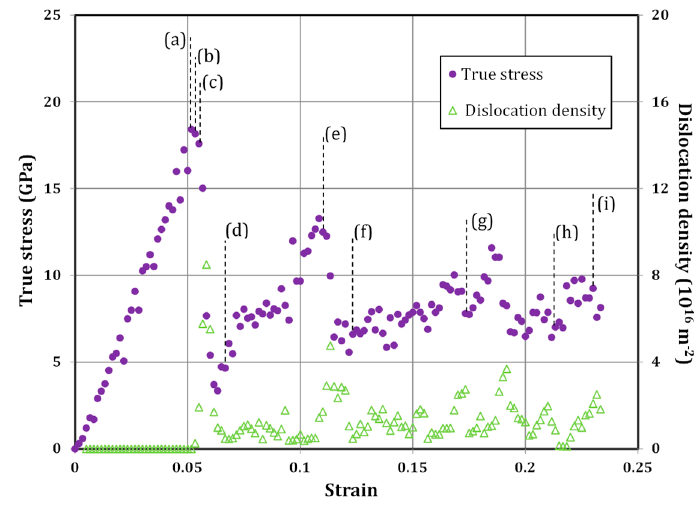
Figure 19. The response of the pillar with D = 15 nm and H = 30 nm during micropillar compression test (after Yaghoobi and Voyiadjis [21]).